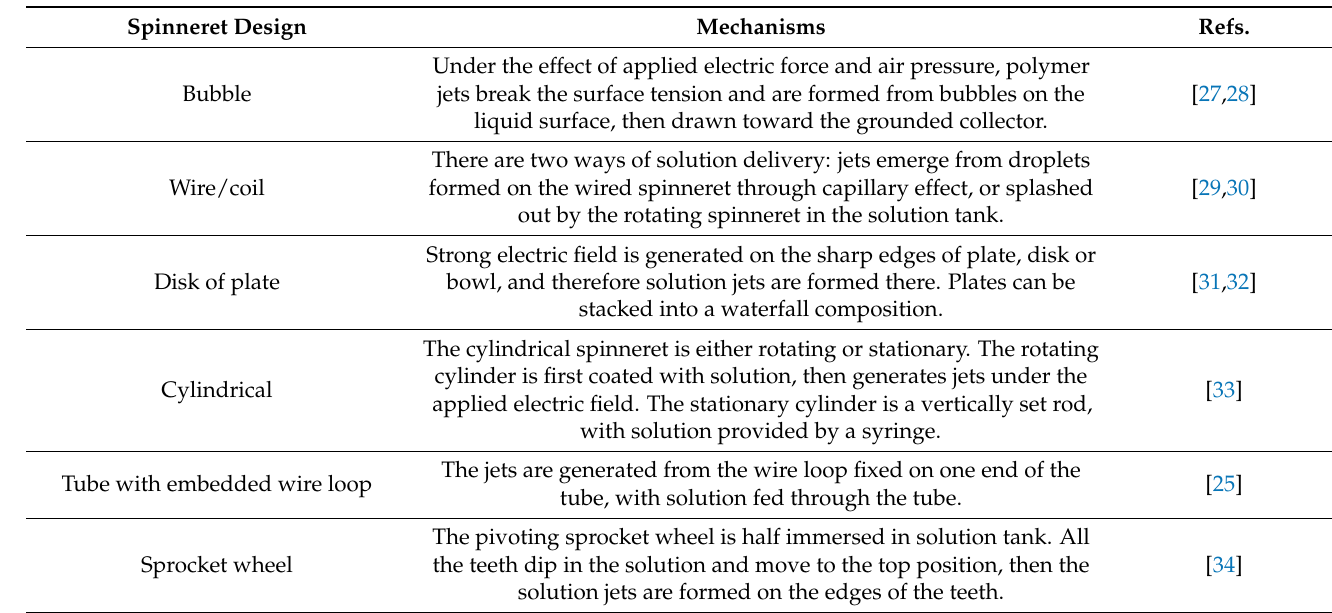
Figure 3. ( a ) Schematic diagrams of the homemade electrospinning setup: i. spiral electrode and ii. cylindrical electrode. Reprinted with permission from ref. [23]. Copyright 2019 John Wiley & Sons, Ltd. ( b ) Electric field profiles of: ( i ) spiral electrode, ( ii ) cylindrical electrode. Reprinted with permission from ref. [23]. Copyright 2019 John Wiley & Sons, Ltd. ( c ) Schematics and photo of the experimental setup of wire loop spinneret. Reprinted with permission from ref. [25]. Copyright 2018 Wiley-VCH Verlag GmbH & Co. KGaA, Weinheim. Table 1. Summary of needleless electrospinning.